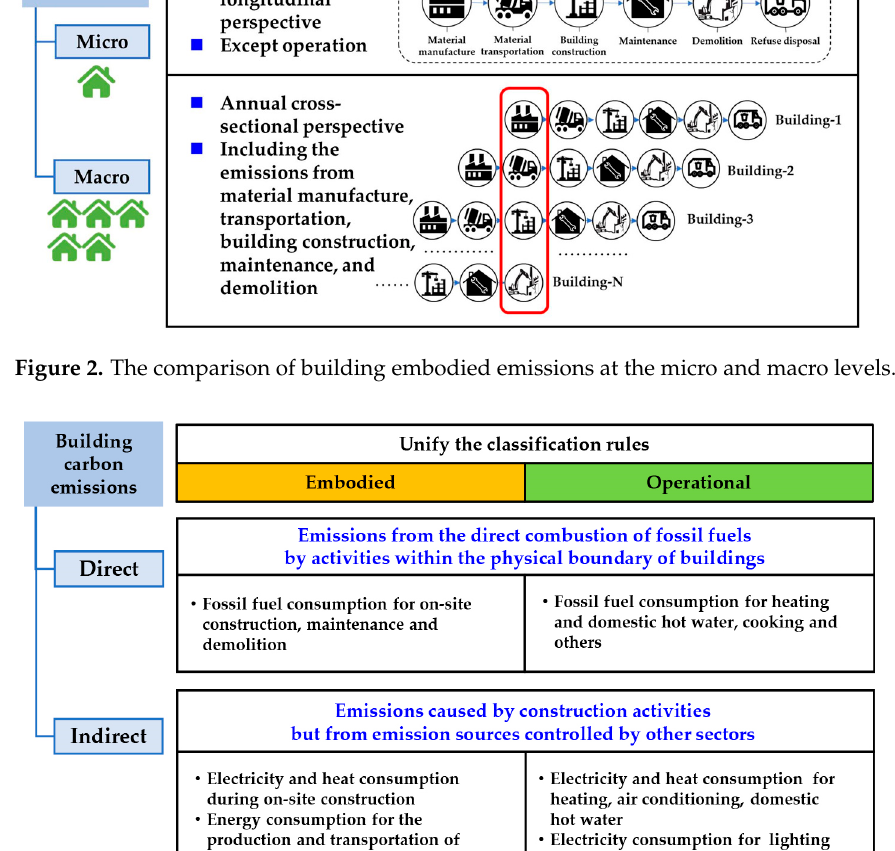
Figure 2. The comparison of building embodied emissions at the micro and macro levels.